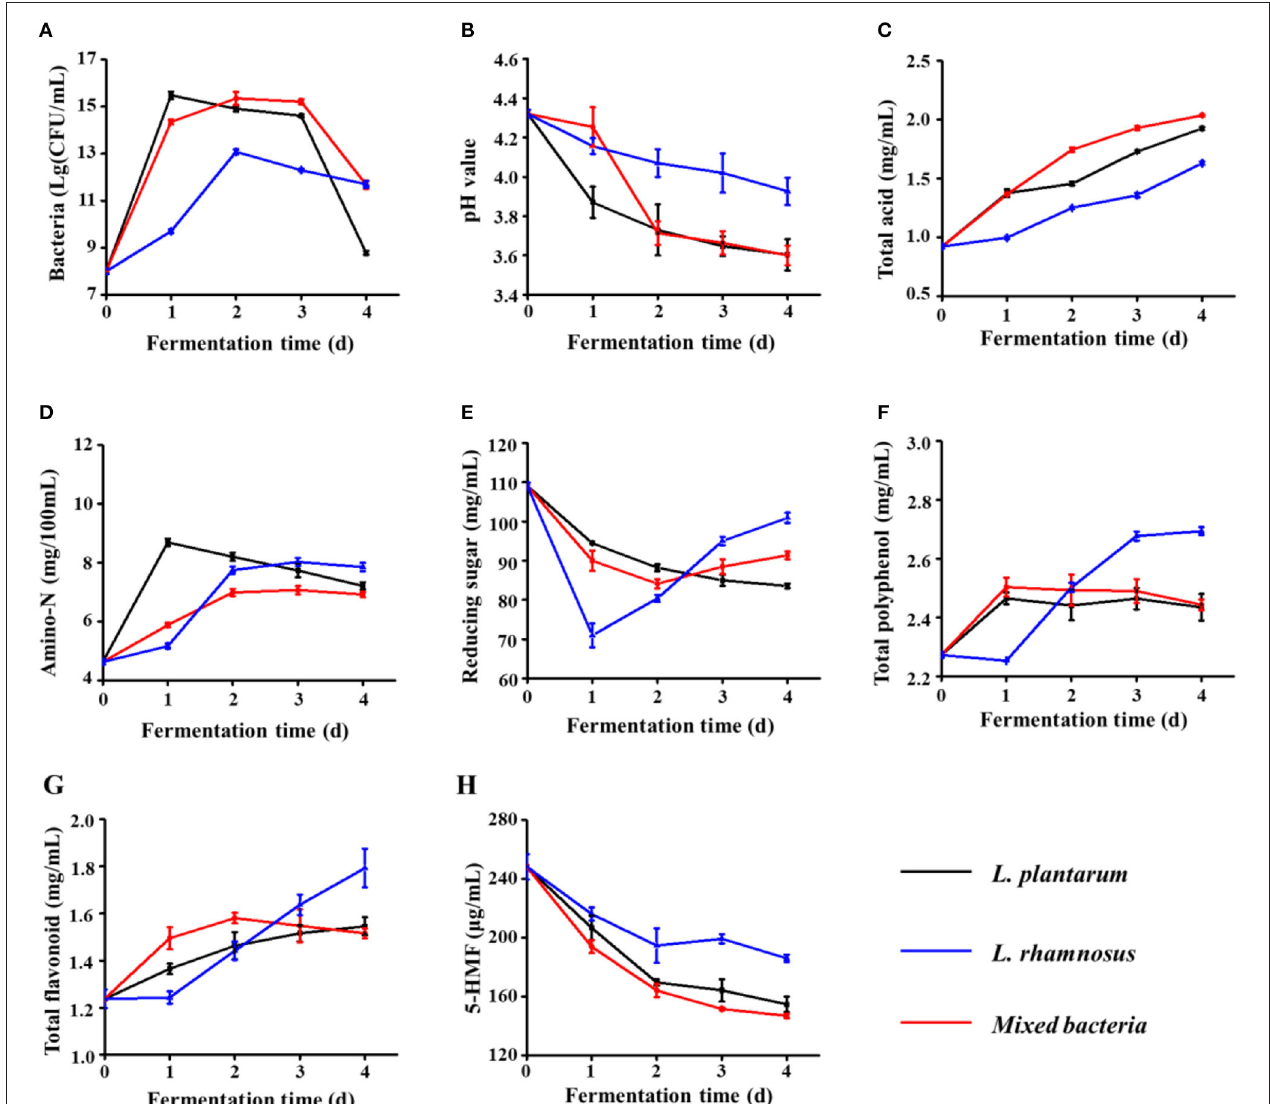
FIGURE 3 | The (A) viable bacterial counts, (B) pH, (C) total acid contents, (D) amino nitrogen (amino-N) contents, (E) total polyphenol contents, (F) total flavonoid contents, (G) reducing sugar contents, and (H) 5-hydroxymethylfurfural (5-HMF) contents of fermented black garlic extracts obtained using different probiotics and different fermentation times. Data are means ± SD ( n =